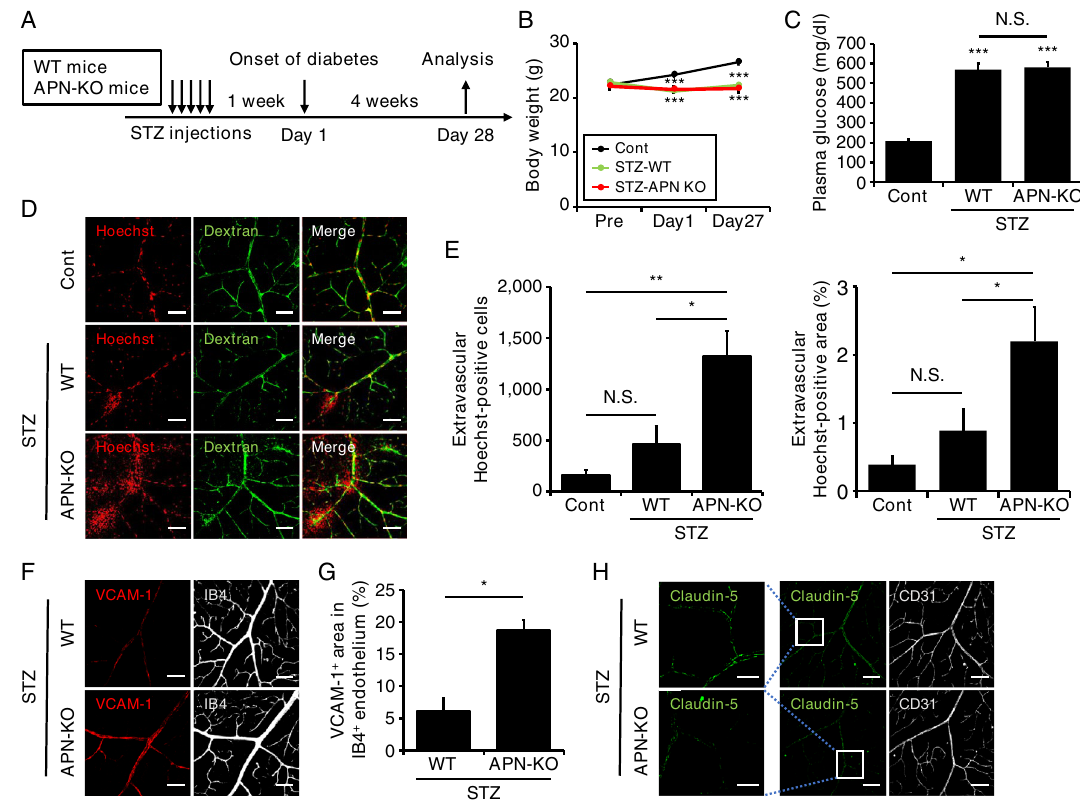
Figure 5. Impact of adiponectin deficiency on retinal vascular damage in streptozotocin-induced diabetes. ( A ) Streptozotocin (STZ) was intraperitoneally administered to 8-week-old male wild-type (WT) and adiponectin knockout (APN-KO) mice for 5 consecutive days. Mice were analyzed at 4 weeks after the onset of diabetes (Day 1). To evaluate retinal vascular permeability, a mixed solution of Hoechst and fluorescein isothiocyanate (FITC)-dextran was transcardially injected into each mouse, and retinas were removed at 5 min after injection. WT mice without STZ injection were also analyzed as control (Cont). ( B and C ) Changes in body weights ( B ) and plasma glucose concentrations under 4-h fasting conditions at Day 27 (the day before analysis). n = 6 for Cont, n = 9 for STZ-WT, and n = 8 for STZ-APN-KO. Data are the mean ± SEM; ***P < 0.001 vs Cont. N.S., not significant (one-way ANOVA with Tukey’s post hoc test). ( D ) Representative immunofluorescence images for Hoechst (red) and FITC-dextran (green). Scale bar = 100 μm. ( E ) Extravascular Hoechst-positive cell numbers (left) and % area (right) were calculated using two randomly obtained sections for each mouse. n = 6 for Cont, n = 9 for STZ-WT, and n = 8 for STZ-APN-KO. Data are the mean ± SEM; *P < 0.05 and **P < 0.01. N.S., not significant (one-way ANOVA with Tukey’s post hoc test). ( F ) Representative immunofluorescence images for vascular cellular adhesion molecule-1 (VCAM-1) (red) and isolectin B4 (IB4) (gray). Scale bar = 100 μm. ( G ) The % area of the VCAM-1-positive region in IB4-positive endothelium. Quantification was performed using two randomly obtained sections for each mouse. n = 4 for STZ-WT and n = 3 for STZ-APN-KO. Data are the mean ± SEM; *P < 0.05 (two-tailed Student’s t-test). ( H ). Representative immunofluorescence images for claudin-5 (green) and CD31 (gray). Scale bar = 25 μm (left panels) and 100 μm (middle and right